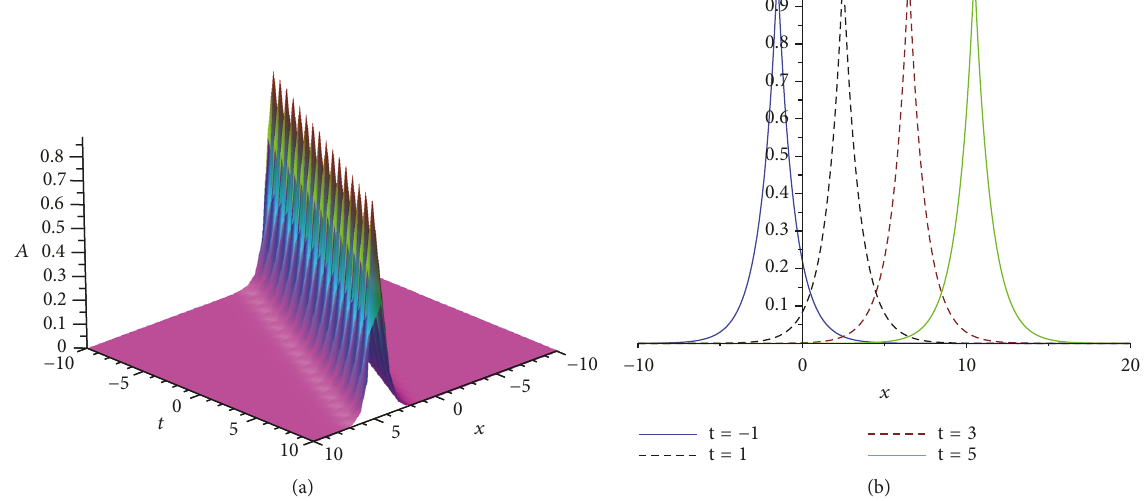
Figure 1: (Colored online) One-peakon solution 𝐴 of (5). (a) 3D-plot for 𝐴(𝑥,𝑡) when 𝑥 0 = 1,𝑡 0 = 0,𝑐 = 1 . (b) The plot for 𝐴(𝑥,𝑡) when 𝑡 = −1, 𝑡 = 1,𝑡 = 3,𝑡 = 5